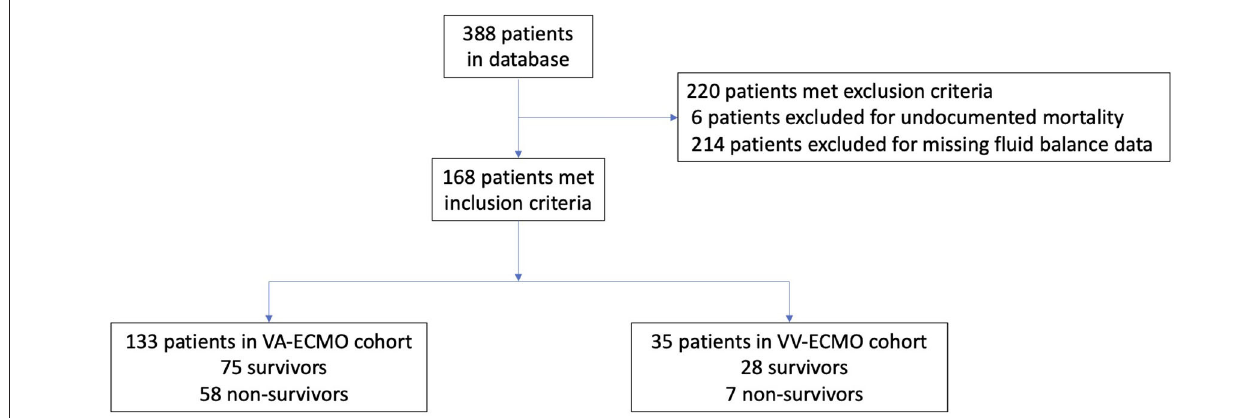
FIGURE 1 | Screened patients and outcomes.